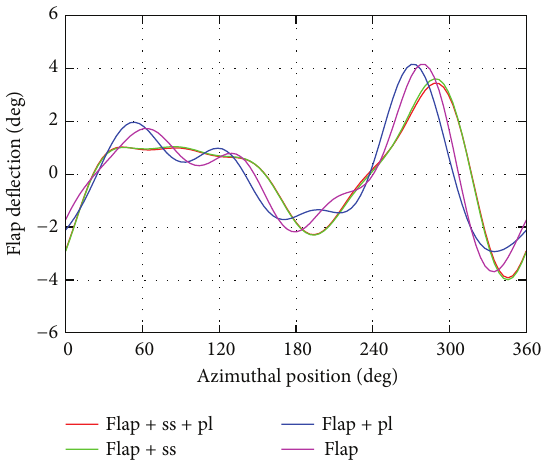
Figure 11: Flap deflections time history.